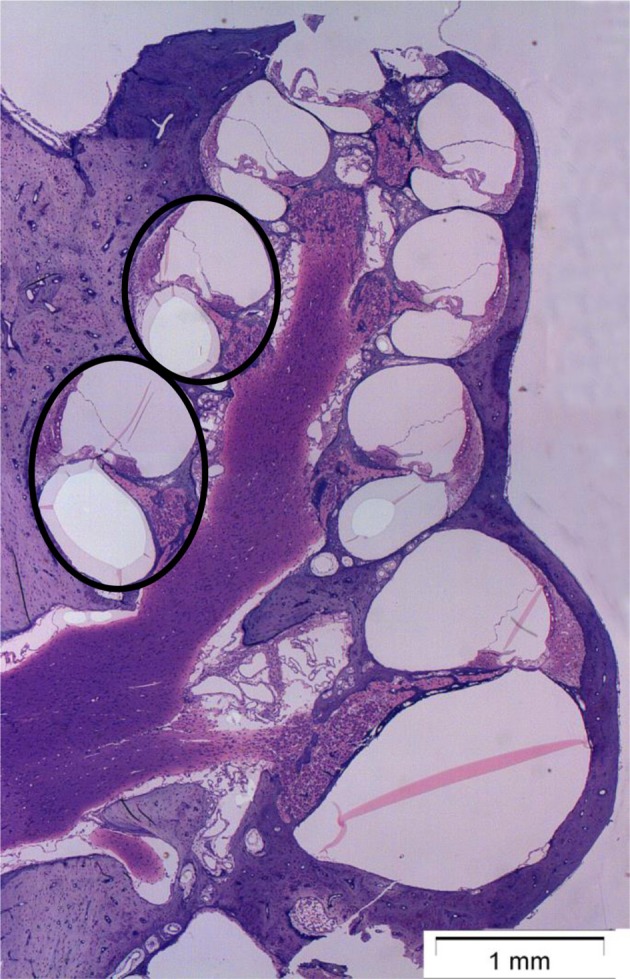
Micrograph showing a mid-modiolar cross-section of a normal guinea pig cochlea. The circles indicate the two points on the basilar membrane, 12 mm (middle turn) and 7 mm (basal turn) from the round window (RW), where the immunoreactivity of synaptophysin, organic cation transporter 2 (OCT2), and copper transporter 1 (CTR1) were analyzed.